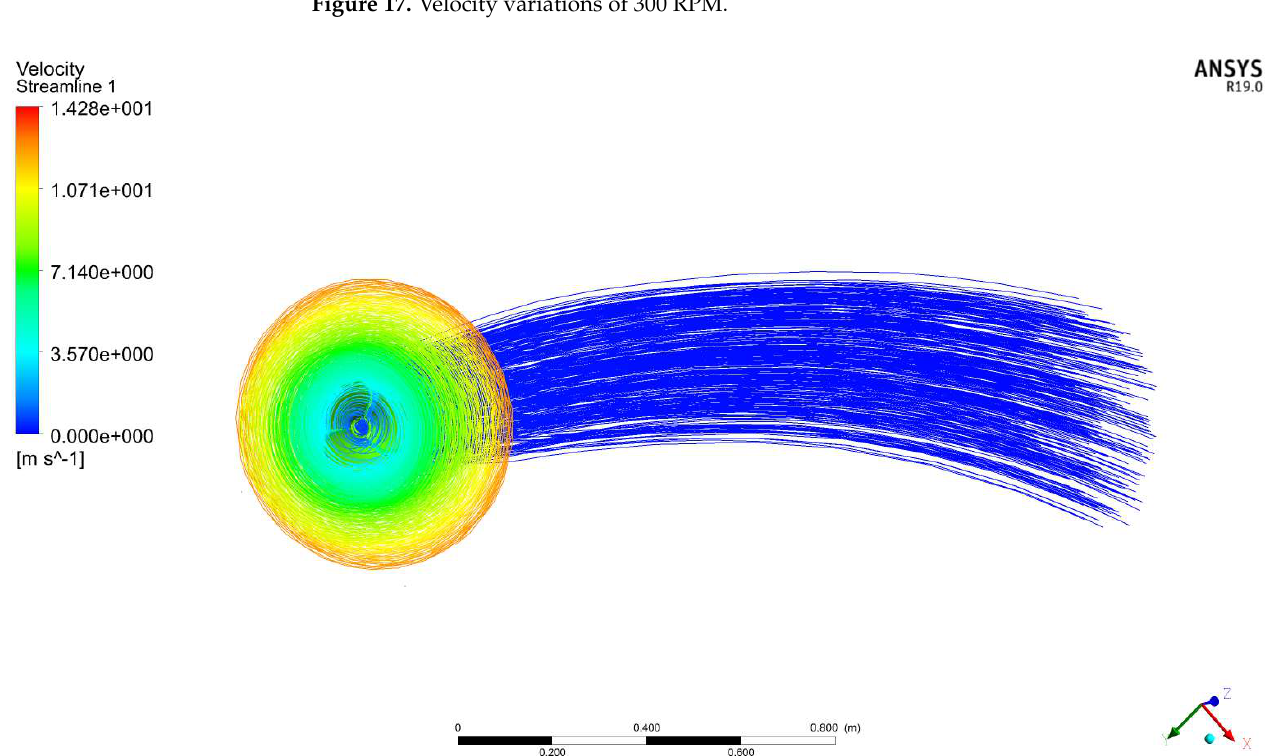
Figure 18. Velocity variations of 400 RPM.